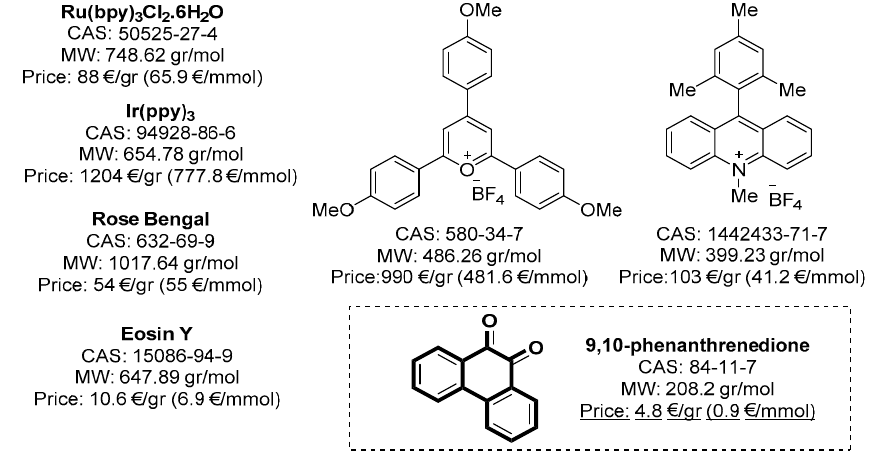
Figure 1. Comparison of commercially available common visible-light photoredox catalysts and 9,10-phenanthrenedione (source: Sigma-Aldrich (2018)).